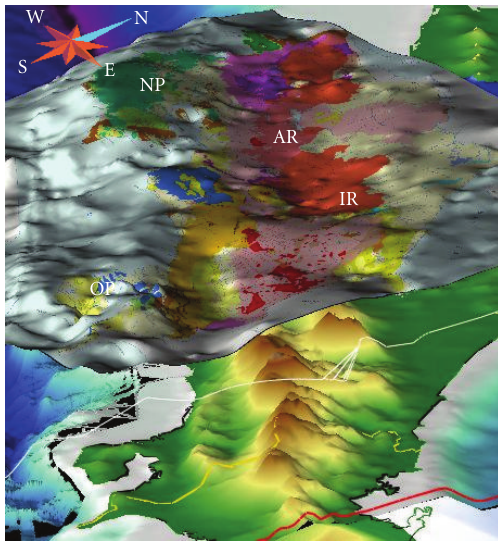
Figure 10: Looking from southeast, we draped the geological map of Figure 8 (bottom) onto the Bouguer gravity map (Free- Air anomaly o ff shore and Bouguer anomaly onshore, Figure 9). This combination provides interesting insight into the “geological” masses that cause the anomalies of the gravity field. For example, the ophiolite of the Nicoya complex, forming the Nicoya Peninsula (NP), is located in the area of the uplifted gravity field map. The active volcanic belt, for example, Iraz´u (IR) and Arenal (AR), in this figure is clearly located in a minimum of the Bouguer gravity field, which points to low densities in the upper